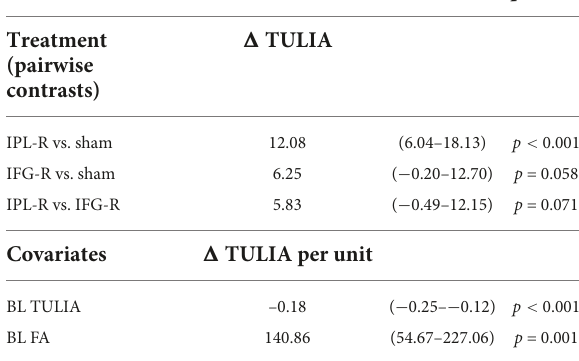
TABLE 3 Linear mixed-effects model: The change in praxis skills due to